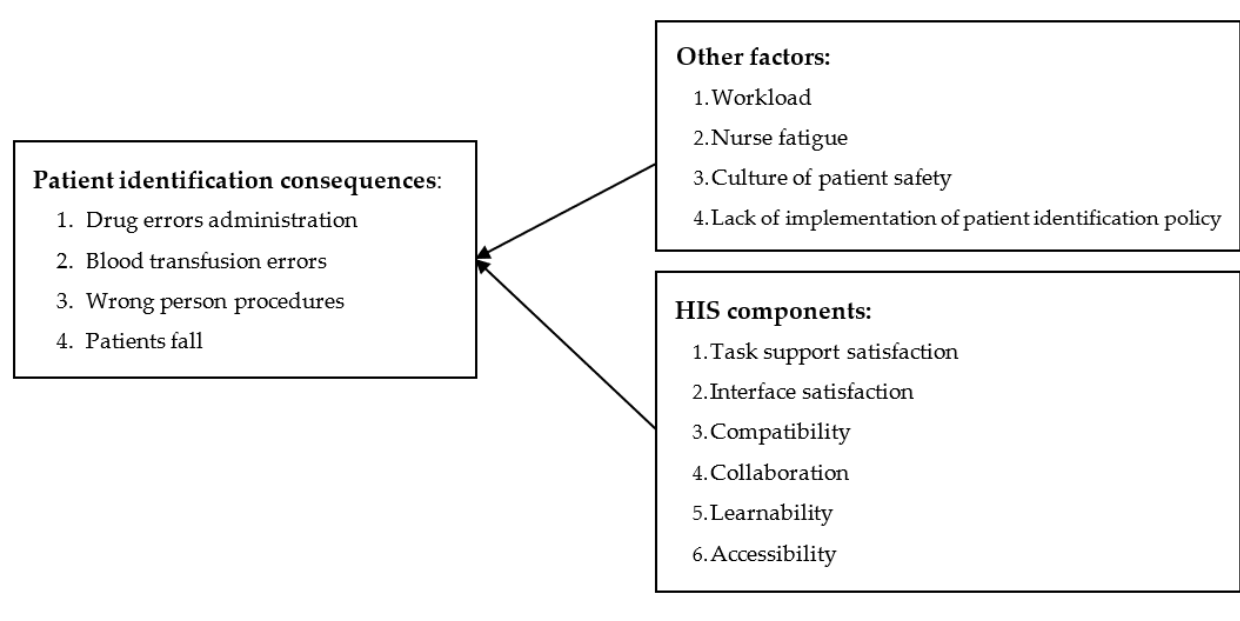
Figure 1. Theoretical framework of the research.